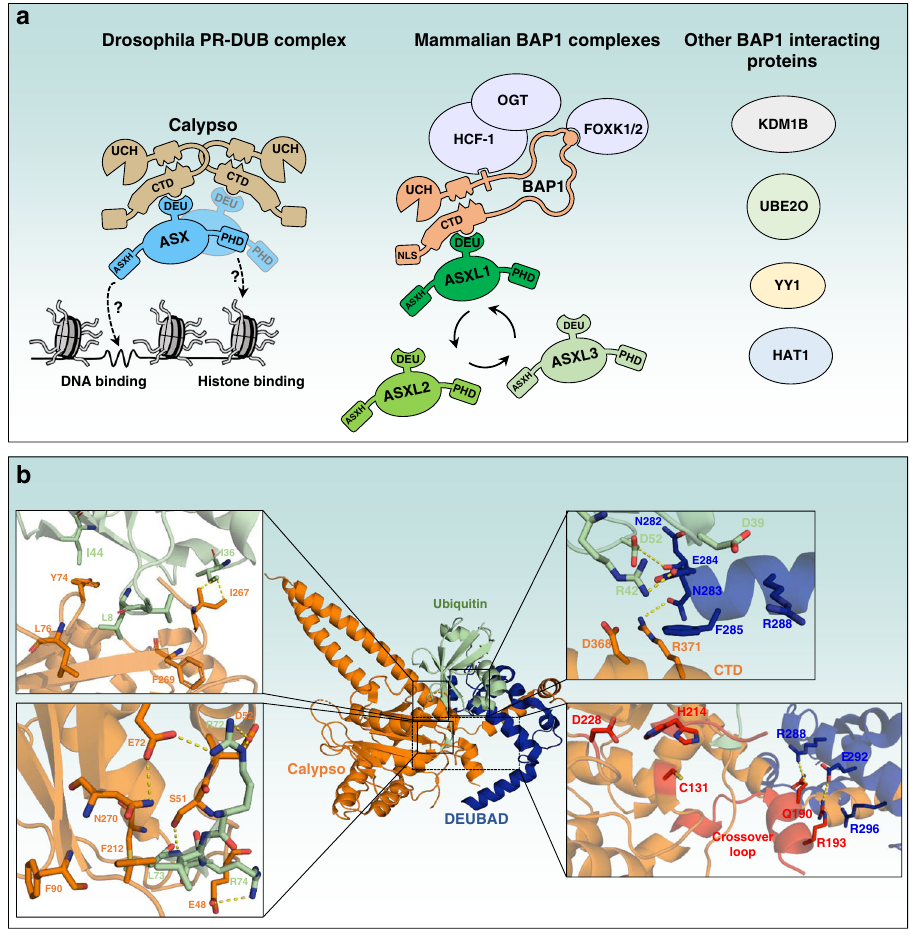
Fig. 3 PR-DUB and BAP1 as major deubiquitinase complexes for H2Aub. a Schematic representation of the Drosophila PR-DUB (Calypso/ASX) and mammalian BAP1 complexes (BAP1/ASXLs). The dotted arrows indicate potential interactions of ASX with chromatin. Calypso and ASX form an oligomer of 2:2 molecules. This speci fi c arrangement is important for the recruitment to chromatin and H2Aub deubiquitination. Note that the mammalian PR-DUB complex (BAP1 complexes) is composed of many additional subunits including HCF-1, OGT, and FOXK1/2. Other BAP1-interacting partners, KDM1B, UBE2O, YY1 and HAT1 are shown. The arrows in circle indicate the mutually exclusive binding of ASXLs to BAP1. b Structural model of the Drosophila core PR-DUB complex (Calypso/DEUBAD (DEUBAD of Asx)) bound to ubiquitin. The model was obtained by superimposing the crystal structure of Calypso/ DEUBAD (PDB: 6HGC) with the UCH-L5-RPN13-Ub crystal structure (PDB: 4UEL). Hydrogen bound interactions between calypso catalytic domain and ubiquitin are shown (left panels). DEUBAD also makes contact with the CTD domain of Calypso and ubiquitin (right top panel). The DEUBAD interaction with Calypso stabilizes Calypso ’ s crossover loop (shown in red, right bottom panel) which promotes Calypso ’ s catalytic activity towards ubiquitin. The triad catalytic sites: C131, H214, D228 are shown in red (right bottom